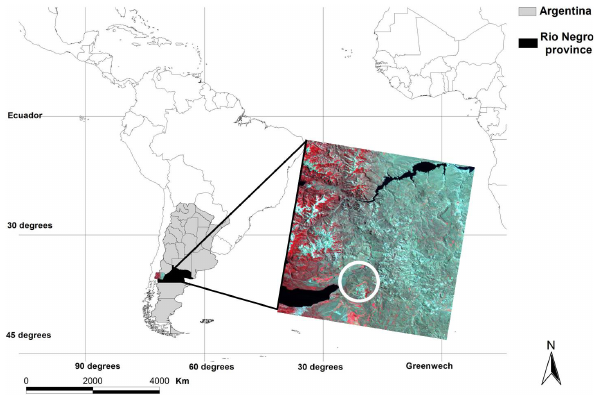
Fig. 1. Study area. Zone of sampling included in image Landsat Path Row 232